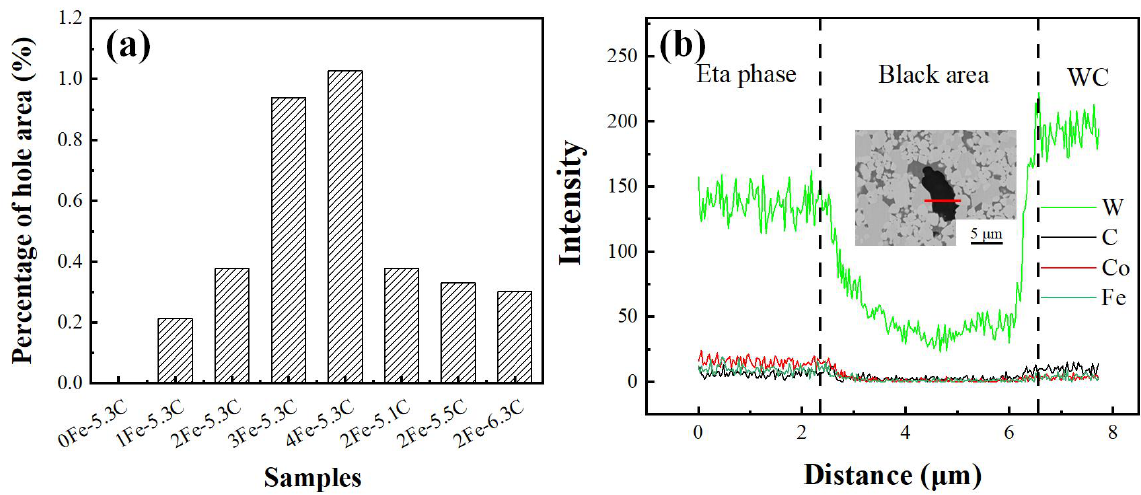
Figure 12. ( a ) Area fraction of the micro-pore in different WC–13 (Co–Fe) composites and ( b ) the EDS analysis around the micro-pore in the 2Fe–5.1C sample.